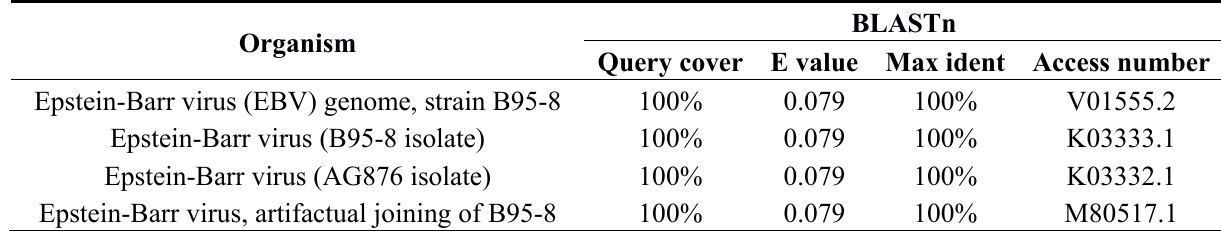
Table 1. The sequence of EBV1 has identity with Epstein-Barr